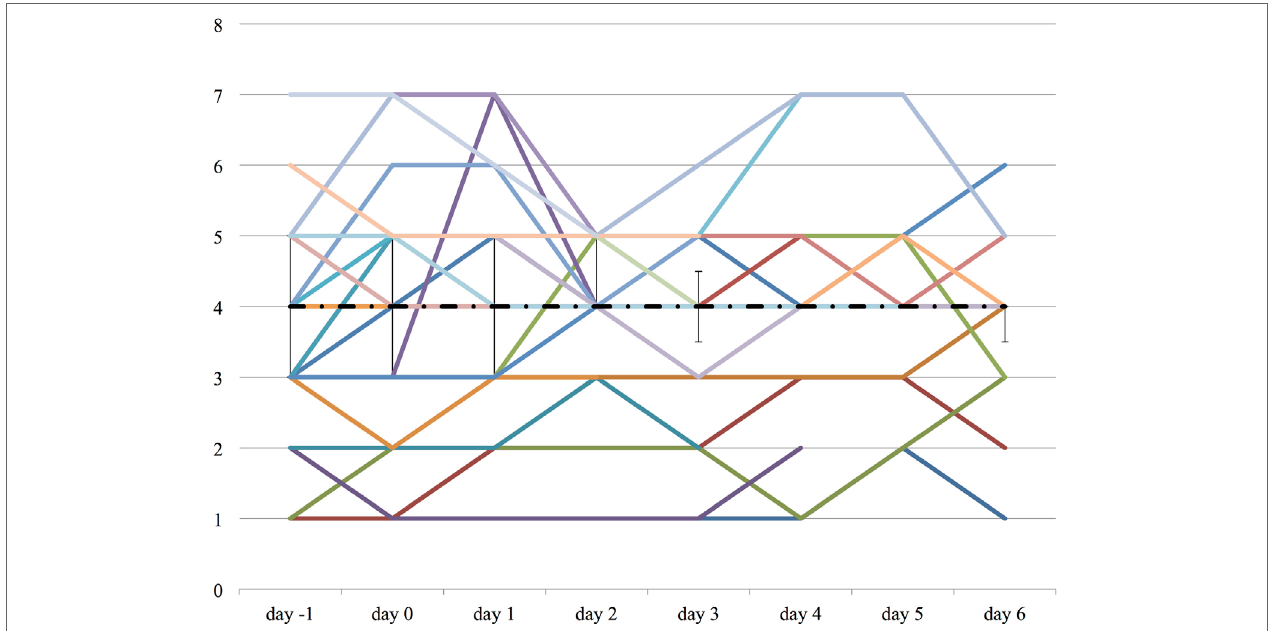
FigUrE 7 | The worst Sedation agitation Score (SaS) score on each day from day − 1 to day 6 . The vertical axis represents SAS score of each patient. The dashed line represents the median SAS score, and the range represents the interquartile range.